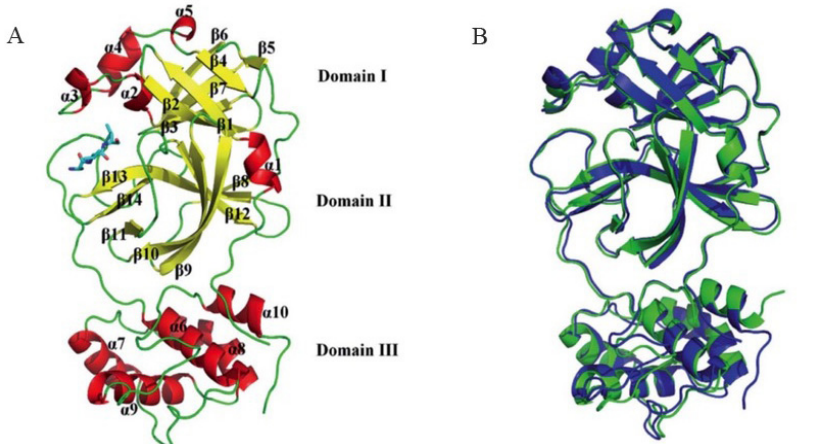
Figure 6. ( A ) The 3D Ribbon representation of 3CLpro-2 (PDB ID: 6LU7) with the N3-peptide-like inhibitor as a stick. ( B ) Superimposed representation of 3CLpro-2 (PDB ID: 6LU7, blue) and 3CLpro-1 (PDB ID: 1UJ1, green) [53,57].